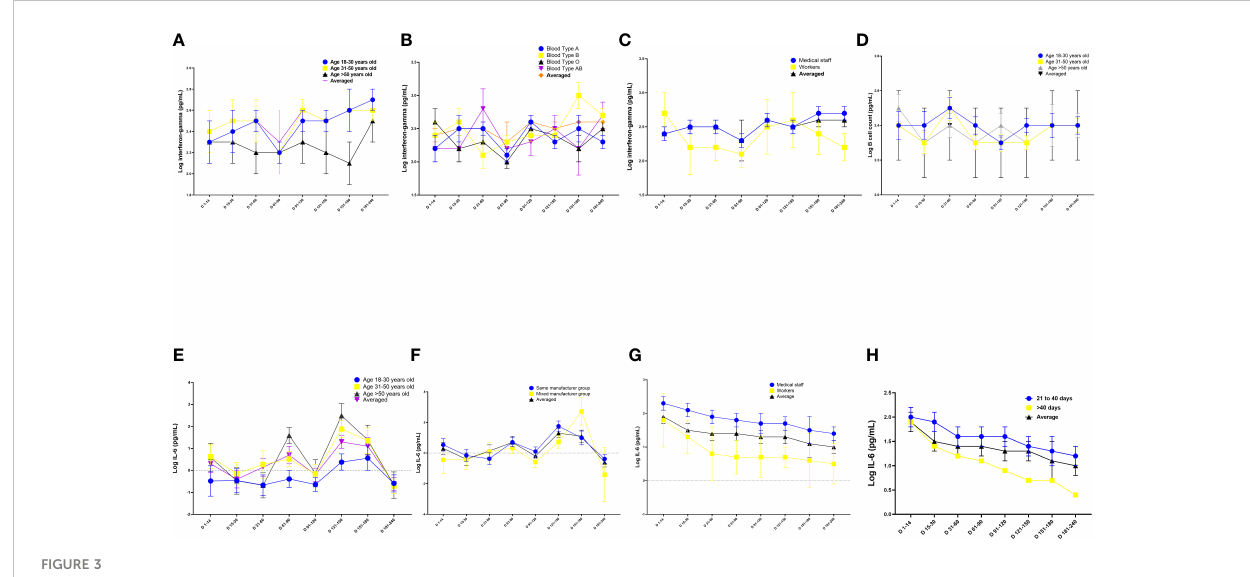
FIGURE 3 Quantitation of cell immune responses on days 1 – 240 following administration of the Chinese inactivated vaccine. (A – C) Kinetics of interferon- gamma levels according to (A) age, (B) blood type, and (C) occupation. (D) Kinetics of B-lymphocyte count according to age. (E – G) Kinetics of interferon (IL)-6 levels according to (E) age, (F) vaccine manufacturer, (G) occupation and (H) interval between doses of vaccination. Data were calculated based on a linear mixed-effects model adjusted for vaccine manufacturer, sex, age, blood type, occupation, and body mass index (BMI). The log-transformed level of interferon-gamma, CD4+ T-cell count, B-lymphocyte count, and IL-6 level were used as independent